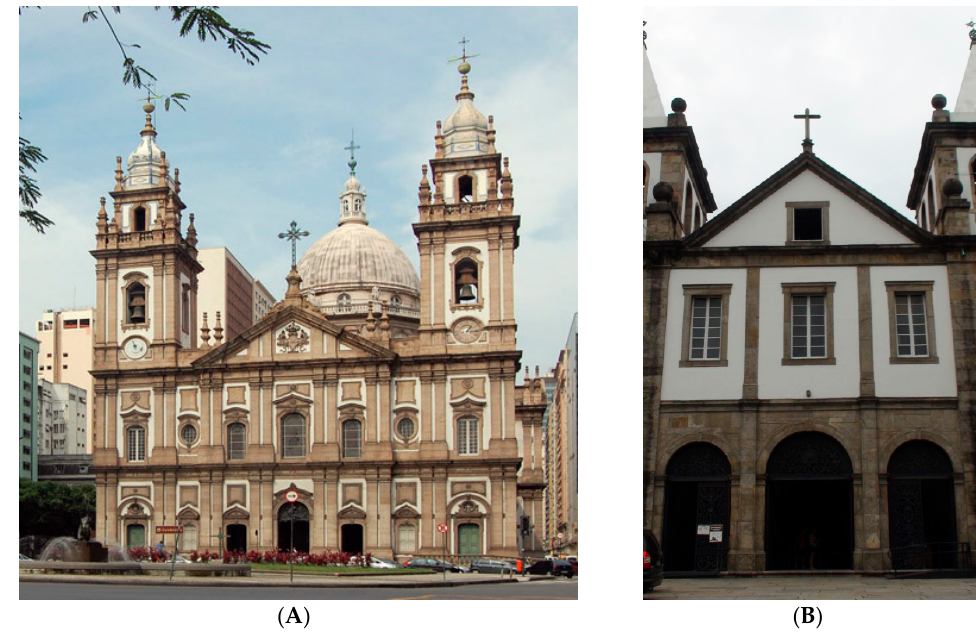
Figure 4. ( A ): Candelária church; ( B ): S. Bento Monastery.